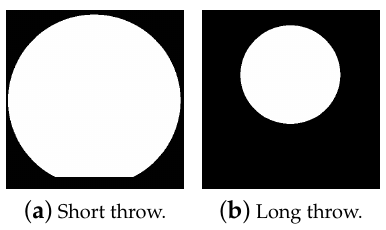
Figure 3. Pixels actually containing values are shown in white for short throw and long throw